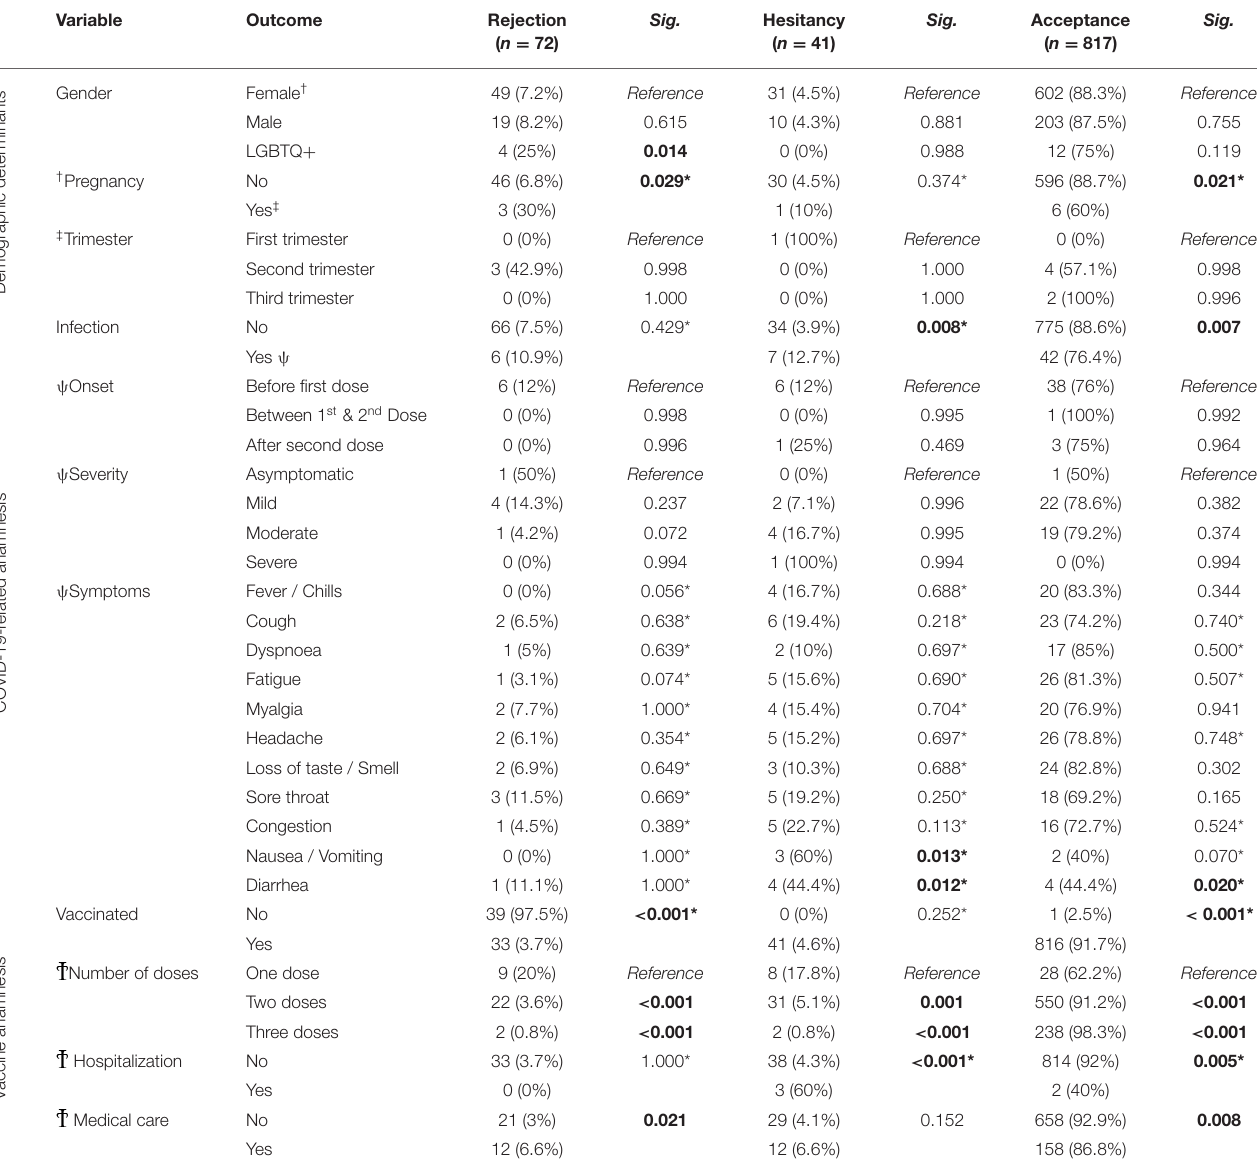
TABLE 6 | Determinants of COVID-19 vaccine-related attitudes of German university students and employees participating in the COVID-19 Vaccine Booster Hesitancy (VBH) Survey, december 2021 ( n = 930). Variable Outcome Rejection ( n = 72)